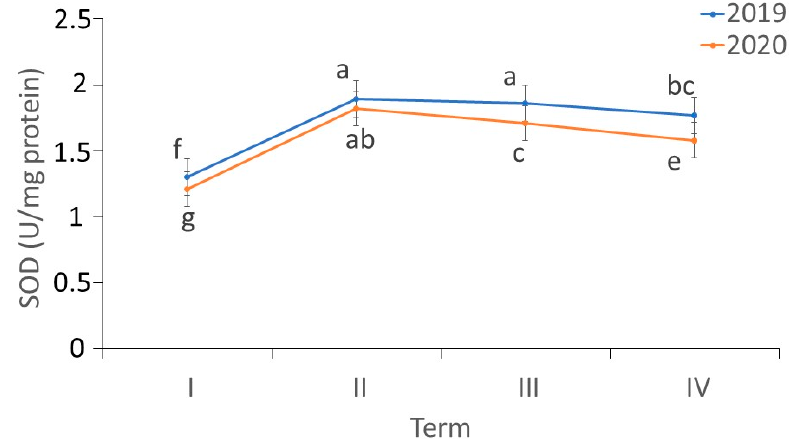
Figure 7. Changes in the SOD activity (U/mg protein) in A. fabae fundatrigeniae during feeding on V. opulus (means ± SD; n = 4). Different letters denote significant differences (one–way ANOVA; Tukey’s test; p < 0.05).